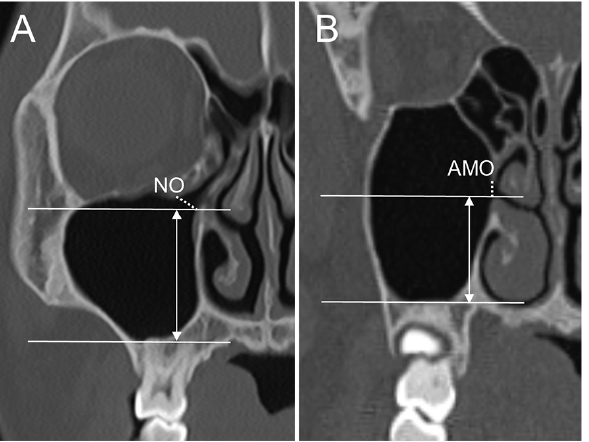
Figure 3. Measurement of the distance between the natural ostium ( A ) or accessory maxillary ostium ( B ) and the maxillary sinus floor located directly below the natural ostium or accessory maxillary ostium. The distance between the most inferior point of the natural ostium or accessory maxillary ostium and the maxillary sinus floor was measured on the same coronal plane as the inferior point of the natural ostium or accessory maxillary ostium.